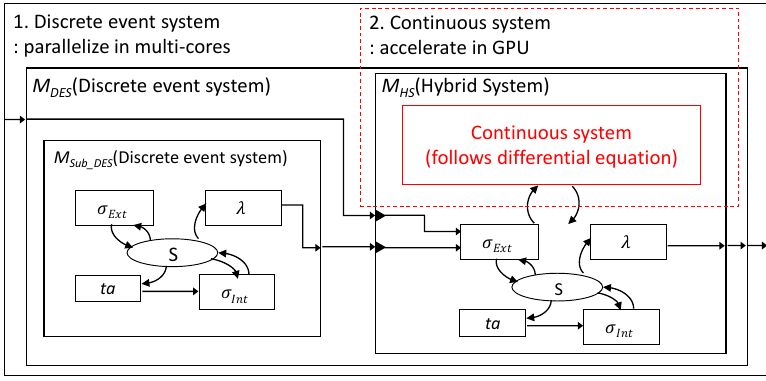
Figure 5. Proposed architecture in terms of model specification.